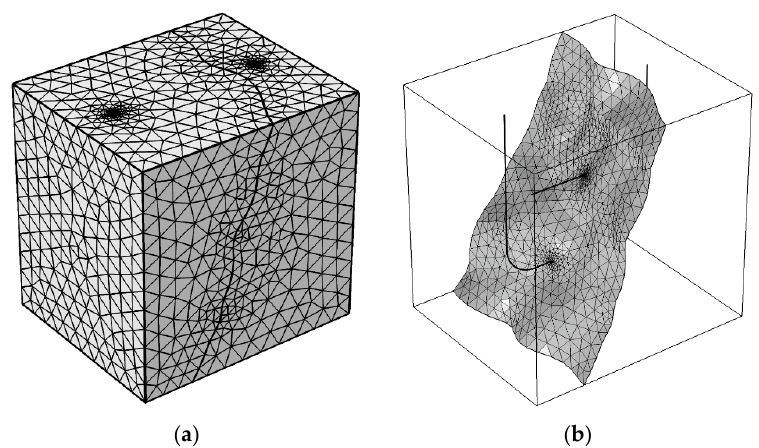
Figure 3. EGS finite element model (grid number: 466,892, node number: 83,502); ( a ) Whole grid structure; ( b ) Fracture grid structure.